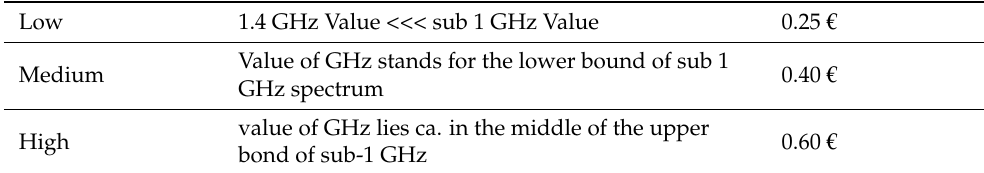
Table 2. The spectrum value of 1.4